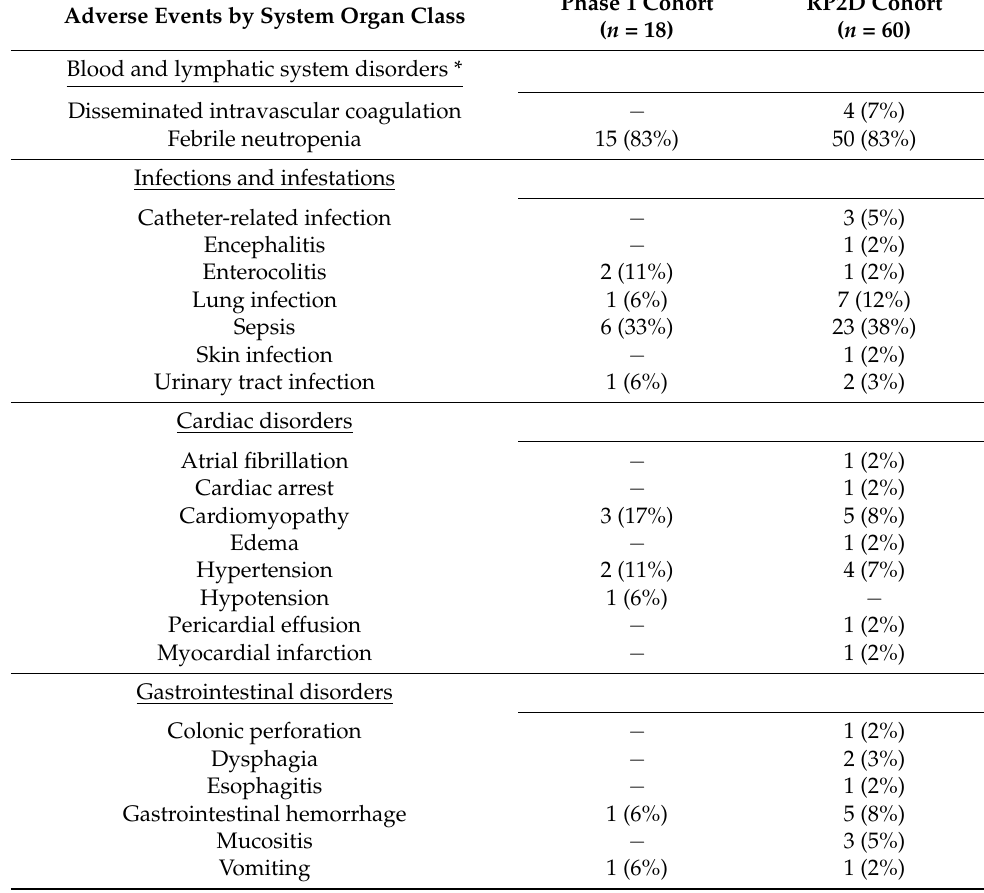
Table 5. Grade 3–4 treatment emergent adverse events (TEAEs) occurring with CLAG-M/GO during the first treatment cycle in patients treated in phase 1 and at the